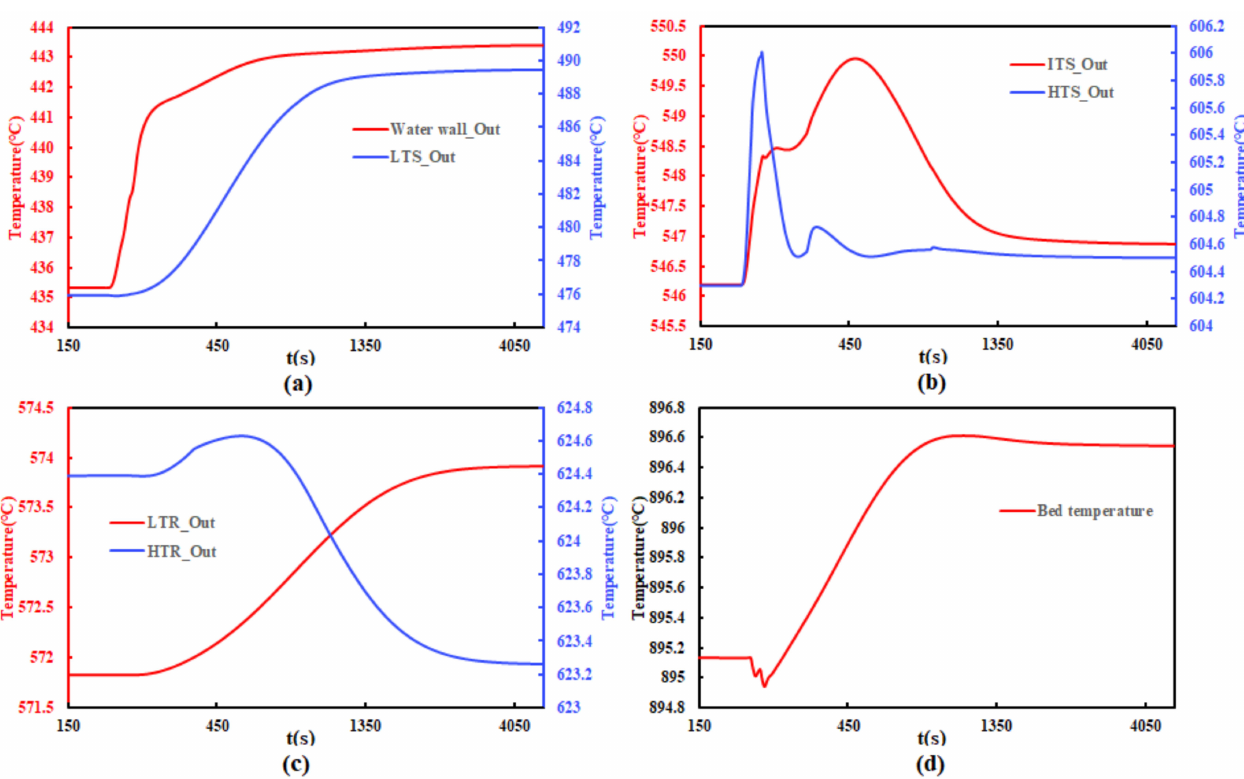
Figure 11. Temperature response when feedwater mass flow decreased by 5%: ( a ) the steam tempera- ture of the water wall outlet and LTS outlet; ( b ) steam temperature of ITS and HTS outlet; ( c ) steam temperature of LTR outlet and HTR outlet; ( d ) bed temperature.